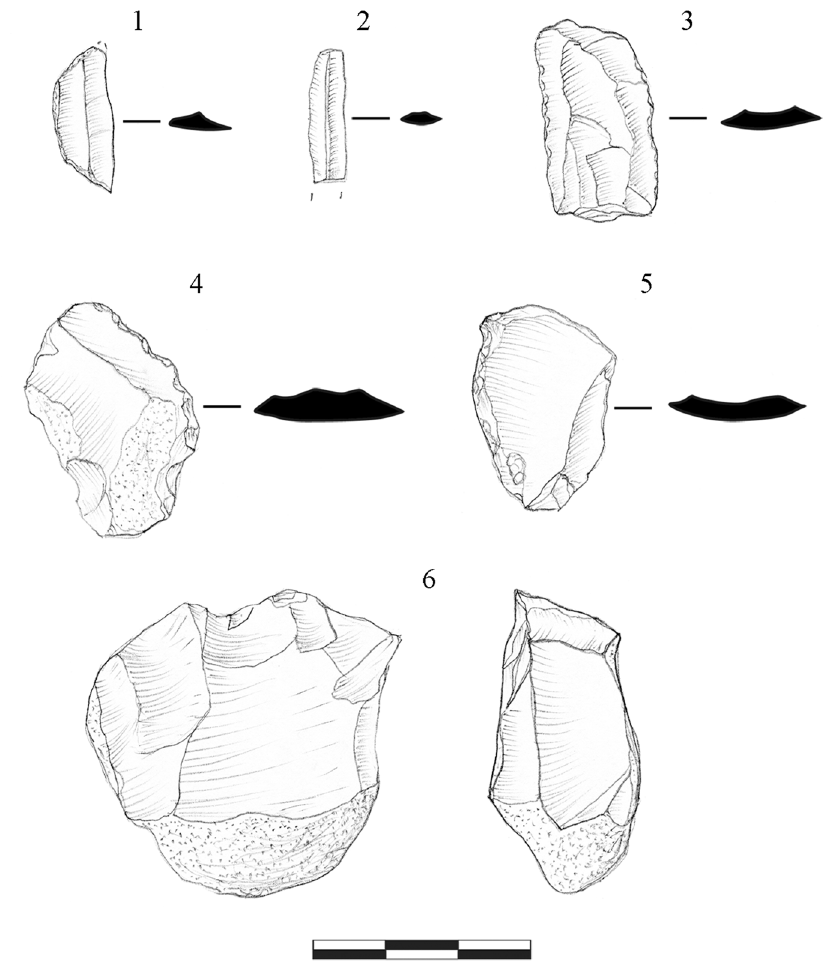
Figure 4: Knapped stone products from Penya Roja de Catamarruc ( 1 ) Geometric microlith – segment; ( 2 and 3 ) Blades; ( 4 and 5 ) Retouched fl akes; ( 6 )